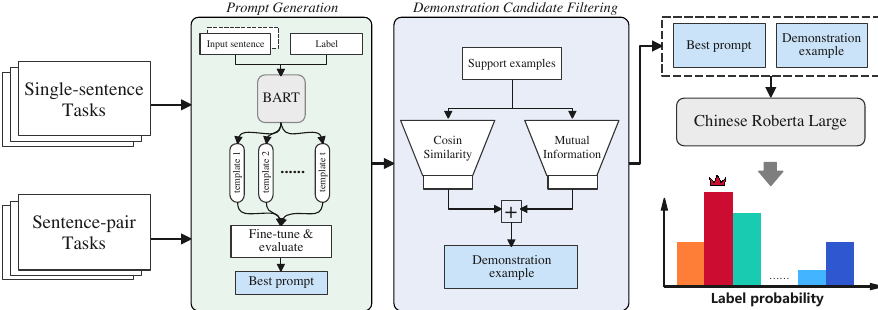
Figure 2. The workflow of the proposed model.The green rectangle represents the prompt generation module in Section 3.2 and the blue rectangle represents the demonstration candidate filtering in Section